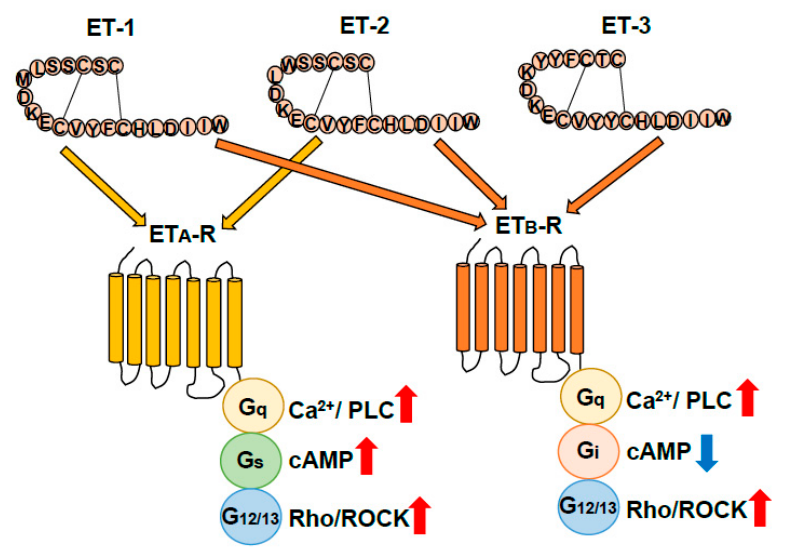
Figure 2. Classification of endothelin receptors. Endothelins (ETs) exert their physiological actions through two G-protein-coupled receptor subtypes, ET A (ET A -R) and ET B receptors (ET B -R). ET A receptor signal pathways mediate Gq, Gs, and G 12/13 resulting in activation of Ca 2+ /phospholipase C (PLC), cAMP, and G 12/13 /Rho/Rock signal pathways. ET B -R signal pathways mediate Gq, Gi, and G 12/13 resulting in activation of Ca 2+ /PLC and Rho/Rock signal pathways and suppression of cAMP signaling pathways